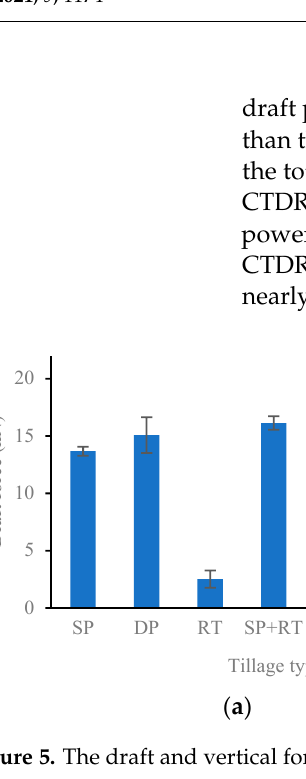
Table 4. The power characteristic of combined tillage implement by simulation.